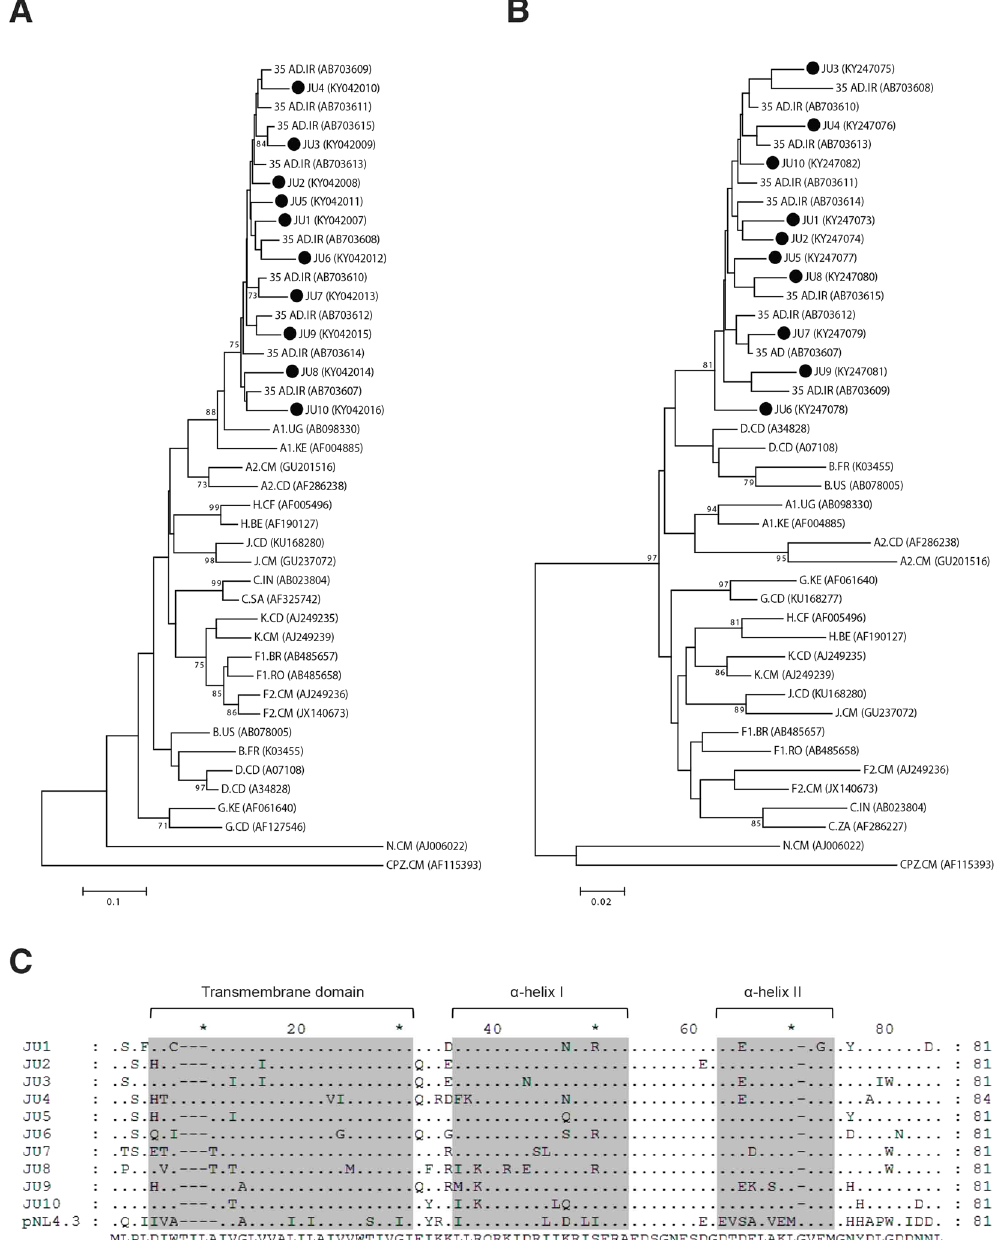
Figure 1. Phylogenetic analysis of HIV-1 isolates. ( A ) DNA sequences of the Vpu alleles were aligned with Vpu of HIV-1 group M reference sequences. A phylogenetic tree was constructed and rooted using Vpu sequences of HIV-1 group N and SIVcpz. Ten Vpu alleles of the clinical isolates are shown with JU (Jundishapur University) suffixed by their respective clone number (1 to 10). For clarity, our isolates are indicated with filled circles (∙). Gene accession numbers are indicated in brackets and the branch lengths represent the sequence dissimilarities. ( B ) A phylogenetic tree was constructed with partial Pol DNA sequences of the HIV-1 isolates and the reference sequences of HIV-1 group M. The tree was rooted with HIV-1 group N and SIVcpz. ( C ) Alignment of the deduced Vpu amino acid sequences from 10 Iranian isolates along with the NL4.3 Vpu. Dots represent identity to the sequence at the bottom and dashes represent gaps. Transmembrane and α -helical domains of Vpu are shaded